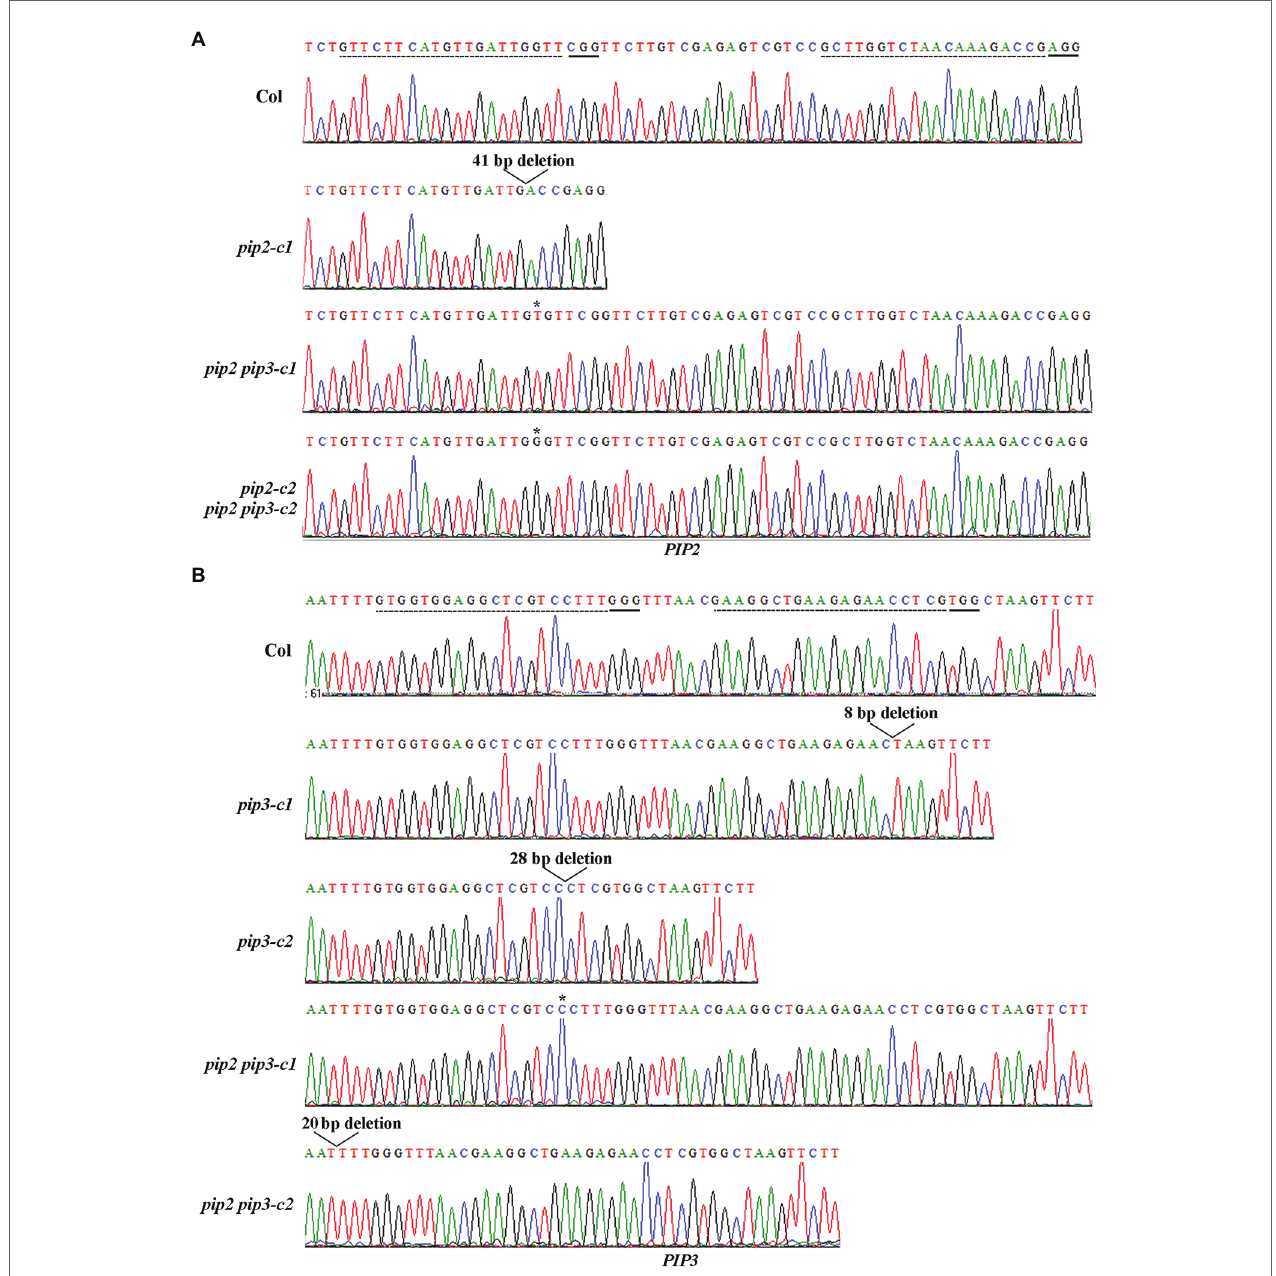
FIGURE 3 | Generation of the pip2 , pip3 , and pip2 pip3 mutants by CRISPR/Cas9 gene editing. (A) Editing status of PIP2 in the pip2 and pip2 pip3 mutants. (B) Editing status of PIP3 in the pip3 and pip2 pip3 mutants. DNA was isolated from leaves collected from early bolting T1 plants or normal bolting T2 plants, and PCR was used to amplify the coding sequence of PIP2 and/or PIP3 . The PCR products were recovered and sequenced, and sequencing results were compared with genome sequence of PIP2 or PIP3 to check the editing status. Dash lines indicate the target sequences, and solid lines indicate the PAM sites.